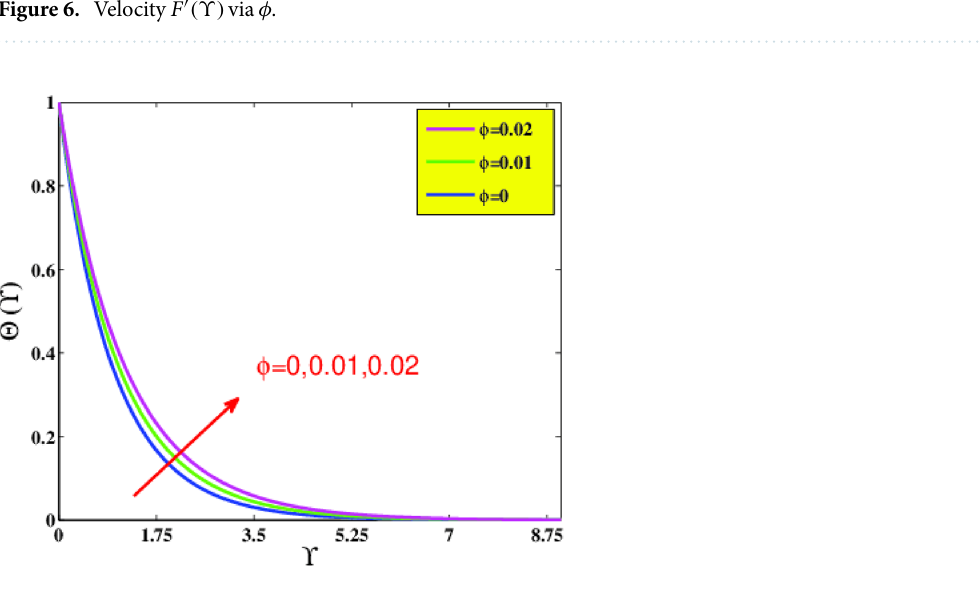
Figure 7. Temperature �(ϒ) via φ